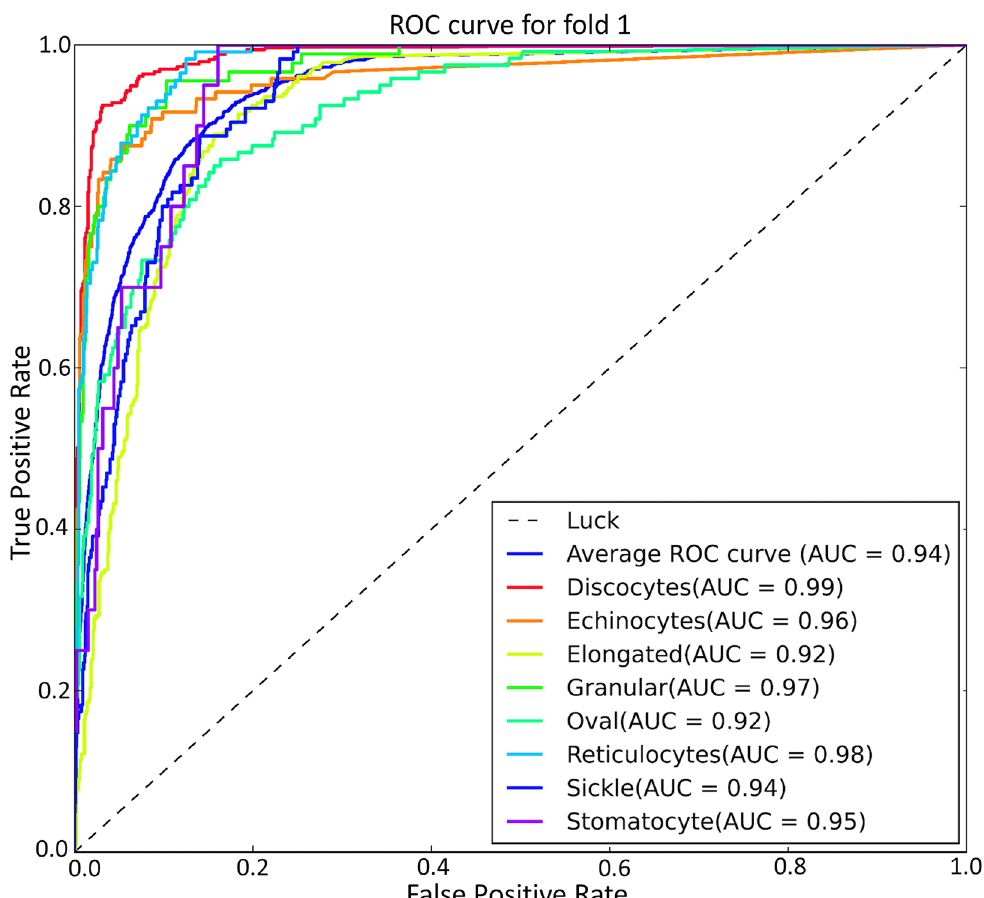
Fig 14. ROC-AUC result for refined 8 types of RBC classification based on “Exp_II” dataset by 5-fold cross validation.